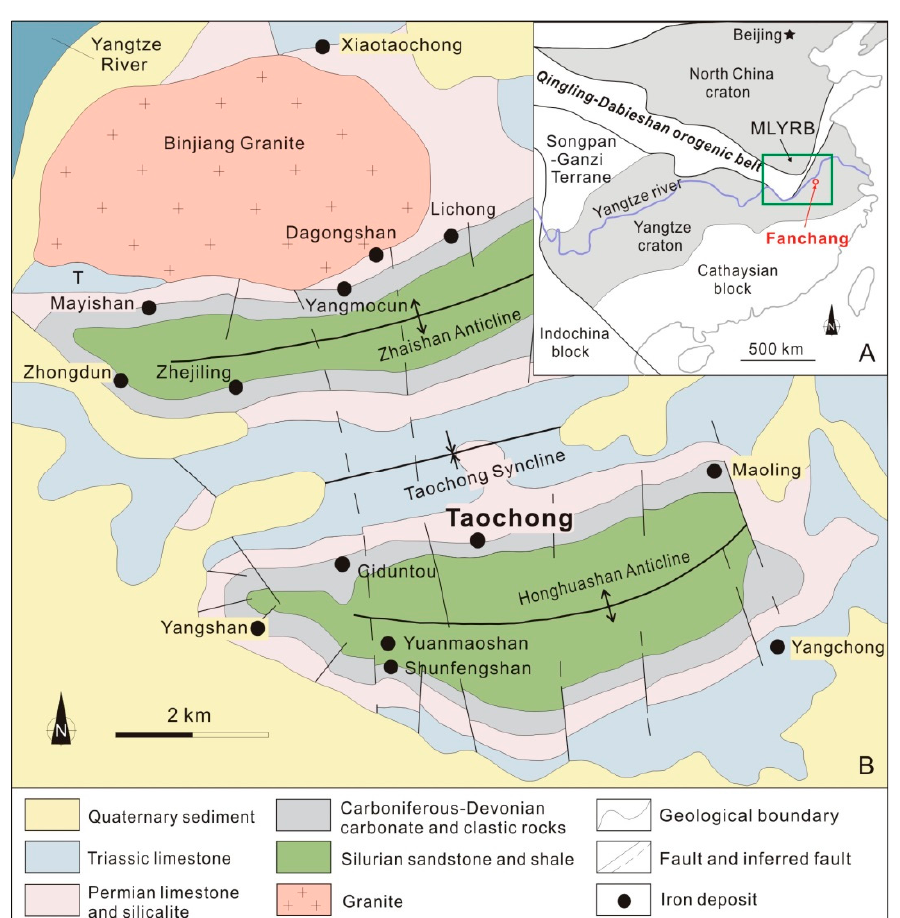
Figure 1. ( A ) Simplified structural map showing the locations of the Middle–Lower Yangtze River metallogenic belt (MLYRB) and Fanchang district (modified from [21,31]). ( B ) Geological map of the Fanchang district (modified from [32]).